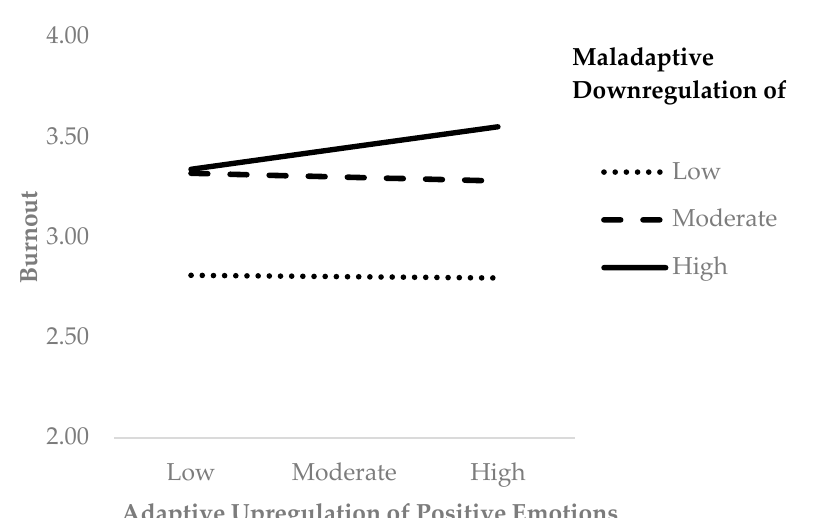
Figure 2. Adaptive upregulation of positive emptions predicting burnout as a function of maladaptive downregulation of negative emotions.